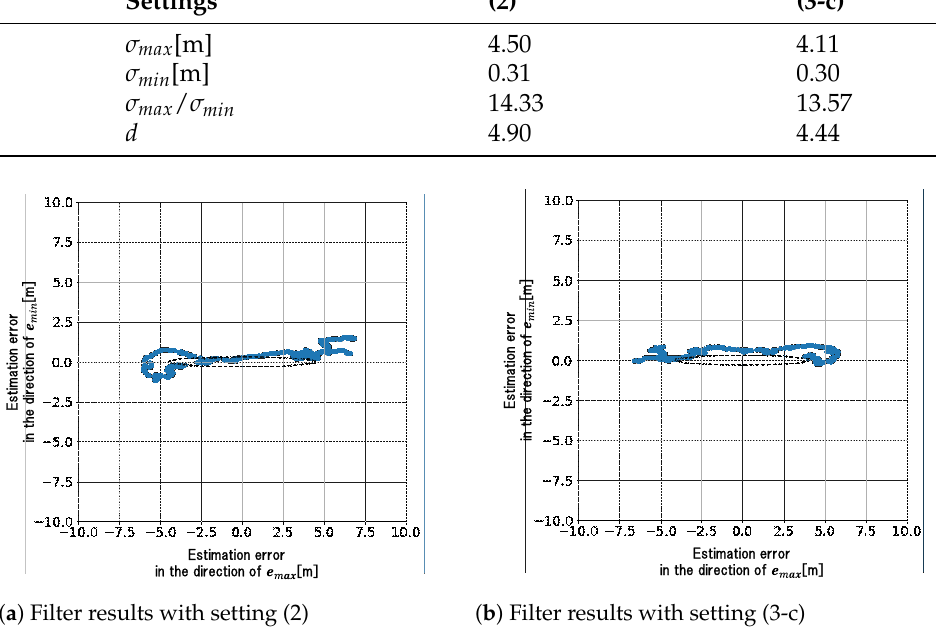
Table 5. Standard deviations from estimation-error covariance Σ , their ratios, and RMSEs. Settings